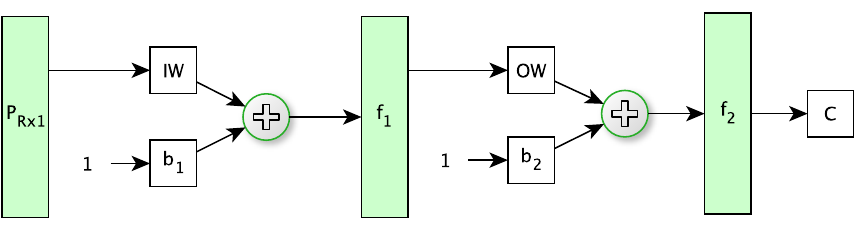
Figure 6. Neuronal network diagram where P is the input vector; IW is the input weights; OW is the output weights; b is the classification result.